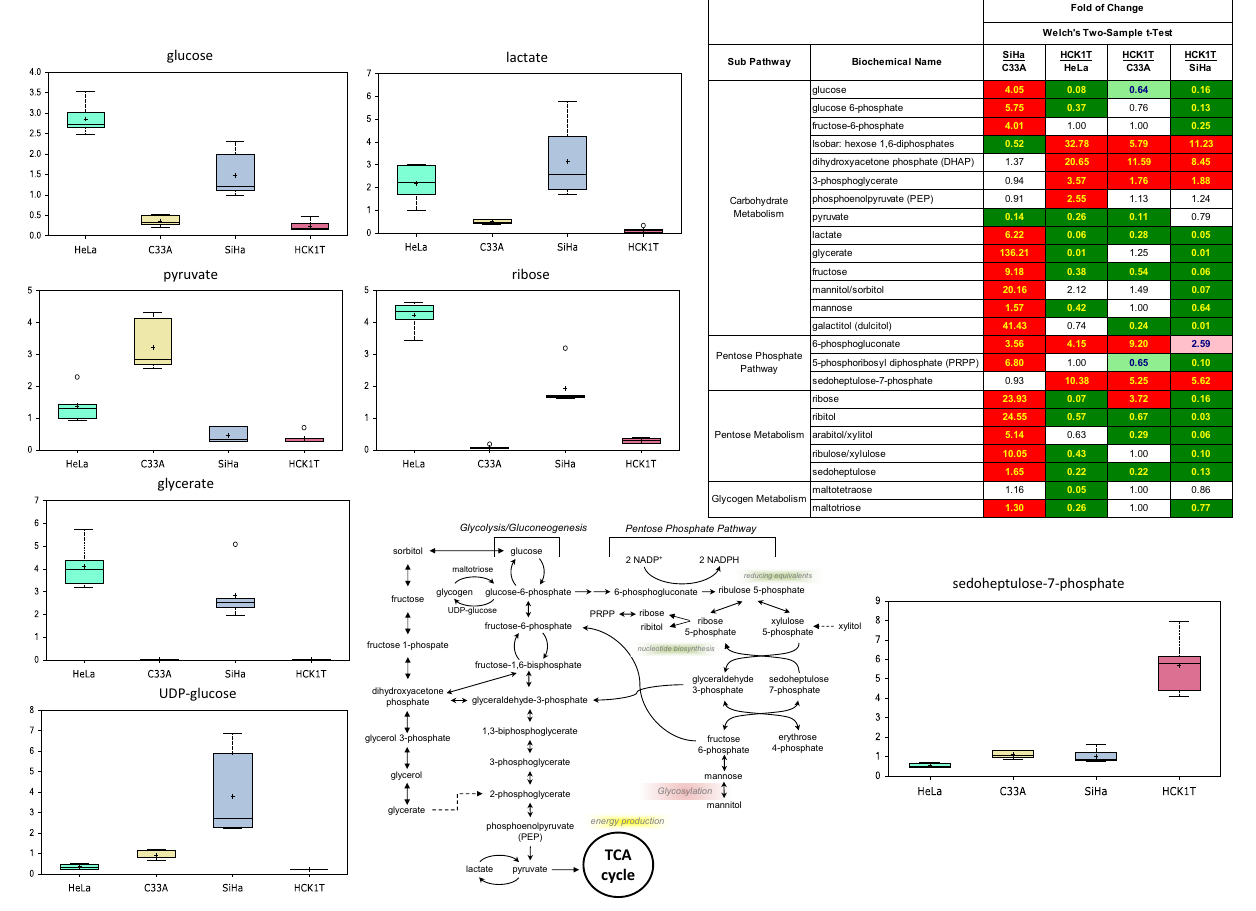
Figure 1. Metabolomic analysis of the altered carbohydrate metabolism of the four cervical cell lines. Selected biochemicals exhibiting salient changes among the four cell types are displayed as box plots. The relevant pathway map and a representative heat map is shown, including the major biochemical changes. Pathway schematics for Figs. 1, 2, 3, 4, 5 and 7, were prepared by GAM at Metabolon, Inc., utilizing established sources, including KEGG (https:// www. genome. jp/ kegg/) and published literature to confirm each biochemical step of the pathway. Green color indicates significant difference ( P ≤ 0.05) between the groups shown, metabolite ratio of < 1.00; light green indicates narrowly missed statistical cut-off for significance 0.05 < P < 0.10, metabolite ratio of < 1.00; red indicates significant difference ( P ≤ 0.05) between the groups shown, metabolite ratio of ≥ 1.00; light red indicates narrowly missed statistical cut-off for significance 0.05 < P < 0.10, metabolite ratio of ≥ 1.00, and non-coloured cells, indicates that mean values are not significantly different for that comparison. Each box plot provides a measure of scaled intensity, normalised by protein content. For further details see Extended Data Table